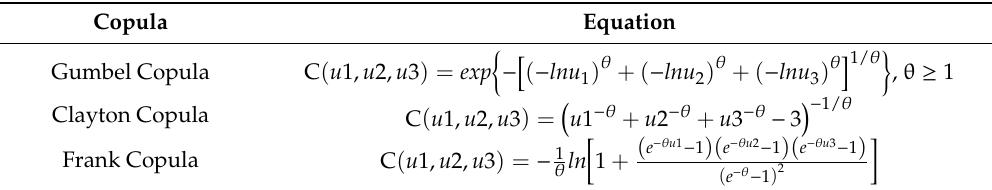
Table 2. Symmetric Archimedean Copula